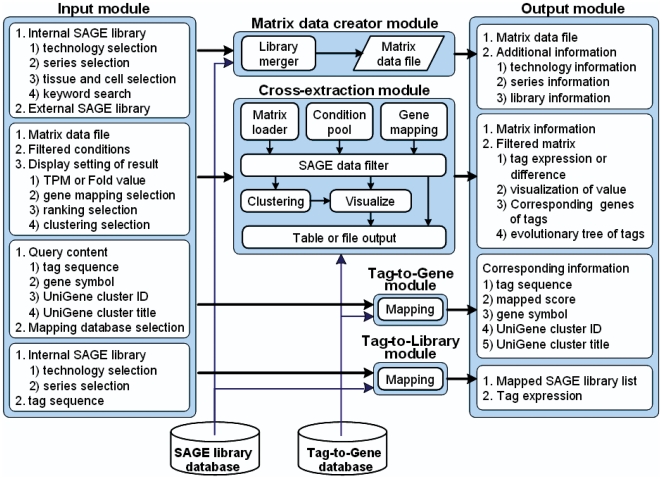
System structure and flowchart of hSAGEing.